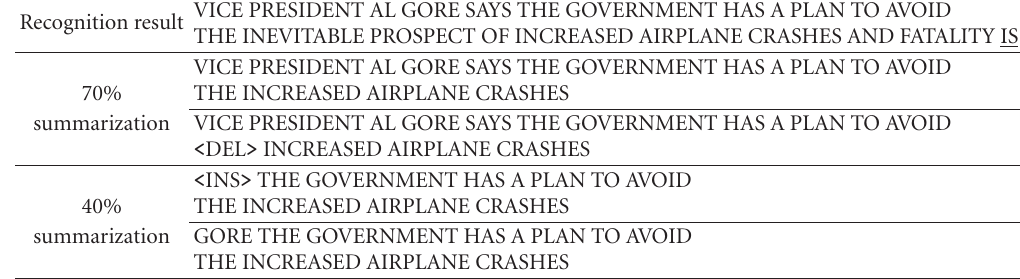
Table 1: Examples of automatic summarization and the corresponding target extracted from a manual summarization word network. In each summarization ratio, upper sentence represents a set of words extracted from summarization network which is the most similar to automatic summarization, and lower sentence represents automatic summarization of recognition results. The underlined word in the recognition result is a recognition error. (cid:18) INS (cid:19) and (cid:18) DEL (cid:19) indicate an insertion error and a deletion error in